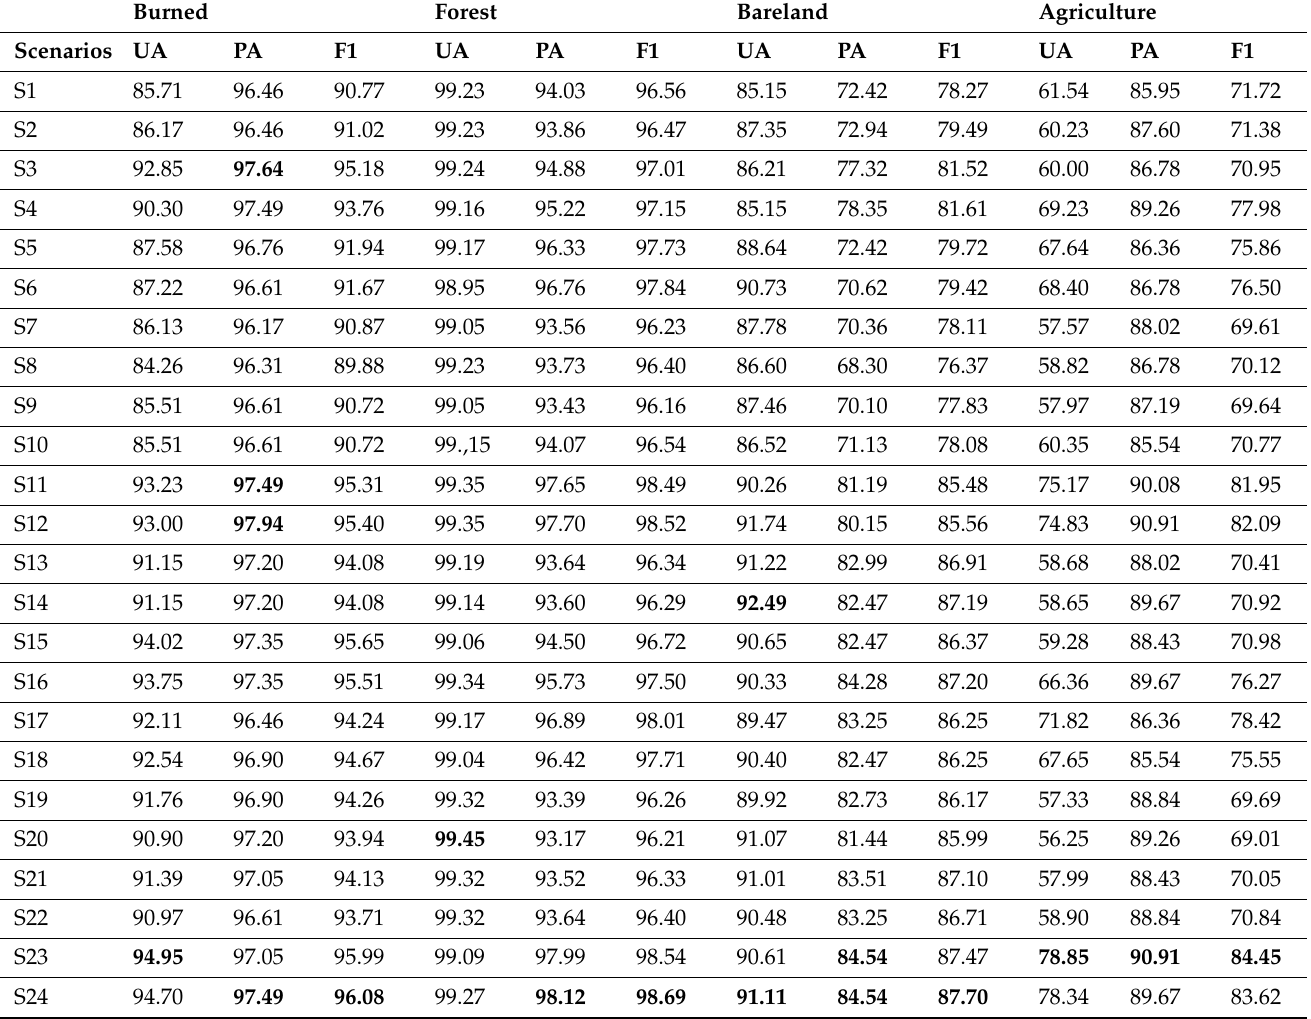
Table A2. Accuracy analysis of each classes in each scenarios. The best result of each class is written in